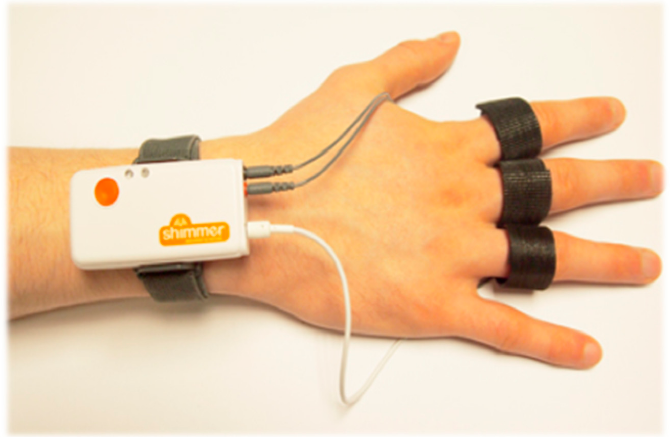
Figure 1. Shimmer system applied for the Blood Volume Pulse (BVP) and Galvanic Skin Response (GSR) recorders.